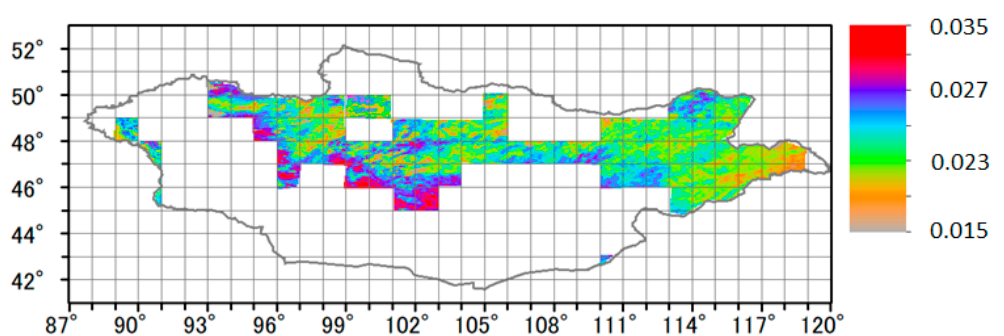
Figure 10. Spatial distribution of annual averaged SbAI values in zone 11 for 2003.